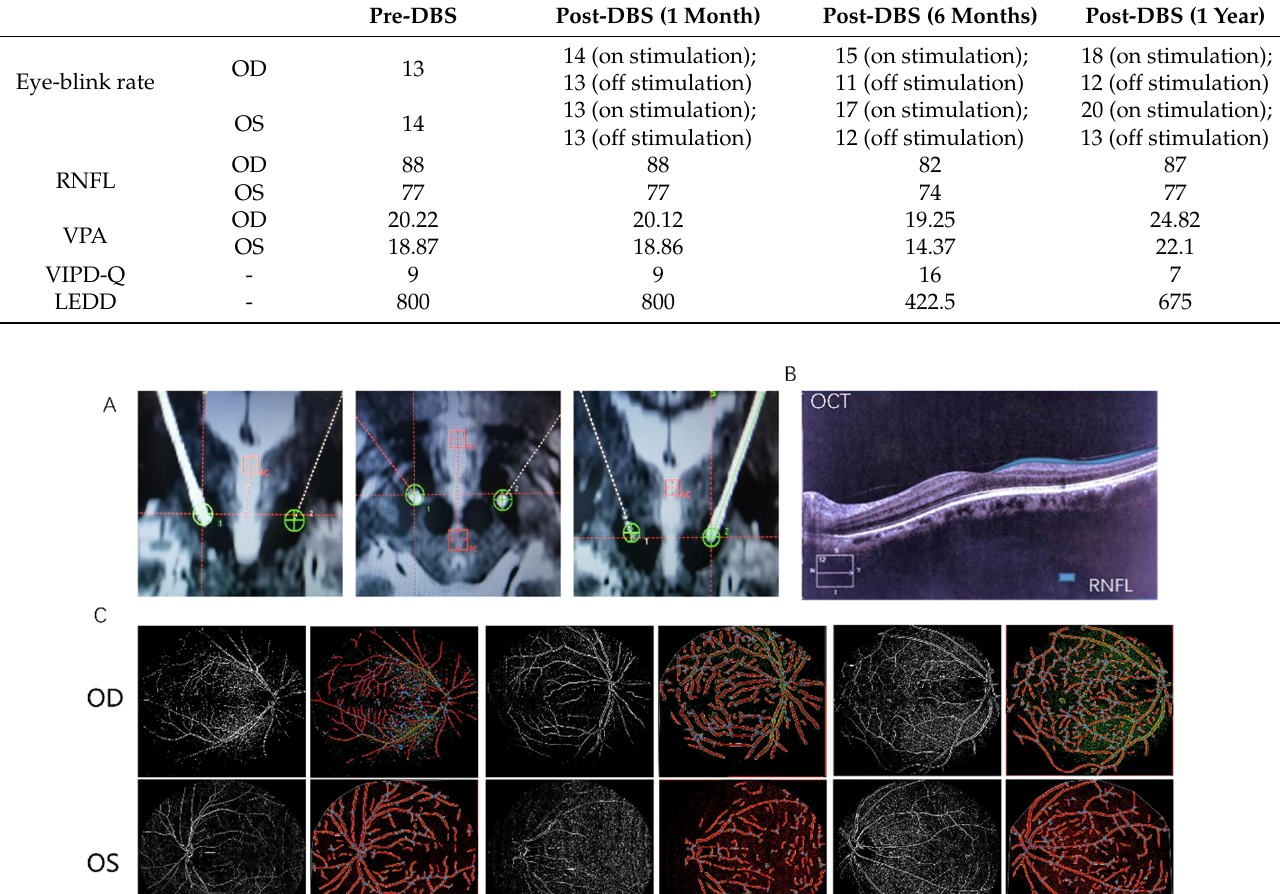
Table 1. Patient’s visual symptom severity pre- and post-STN-DBS.